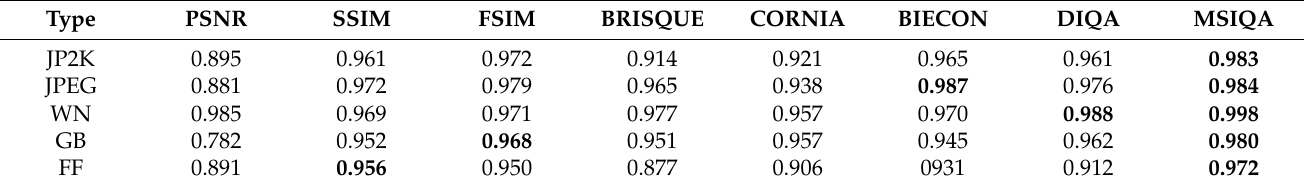
Table 5. Comparison of the SRCC with different methods on LIVE for different distortion